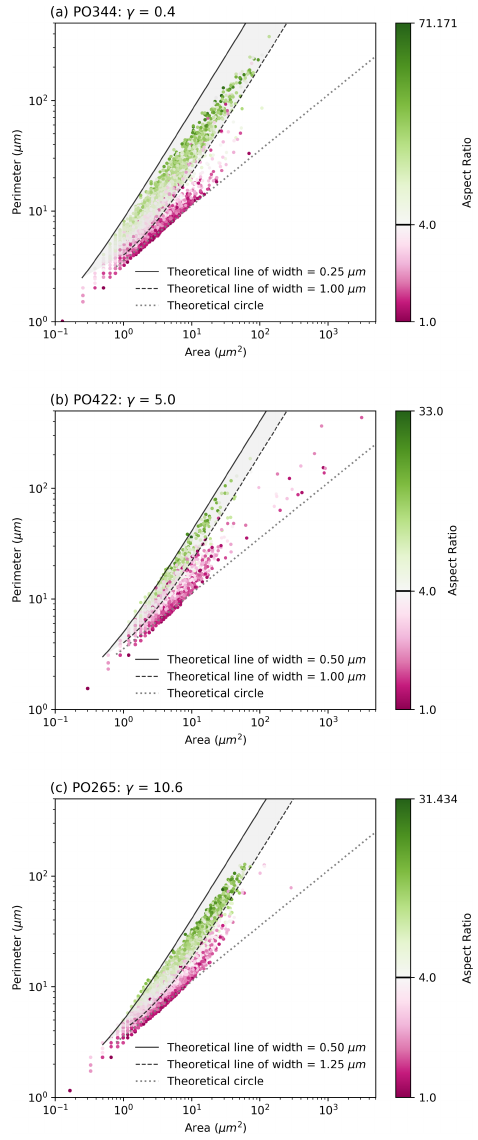
Figure A1. Filtering criteria for grain boundaries and pores.